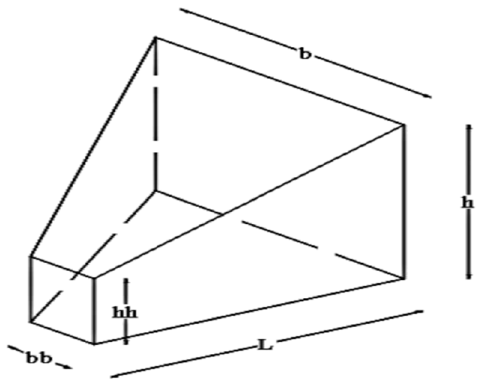
Figure 1: Thrust block of a horizontal bend for AAWA ( American Water Works Association 1999, 2004, 2008, 2009 ) [ 1 ]